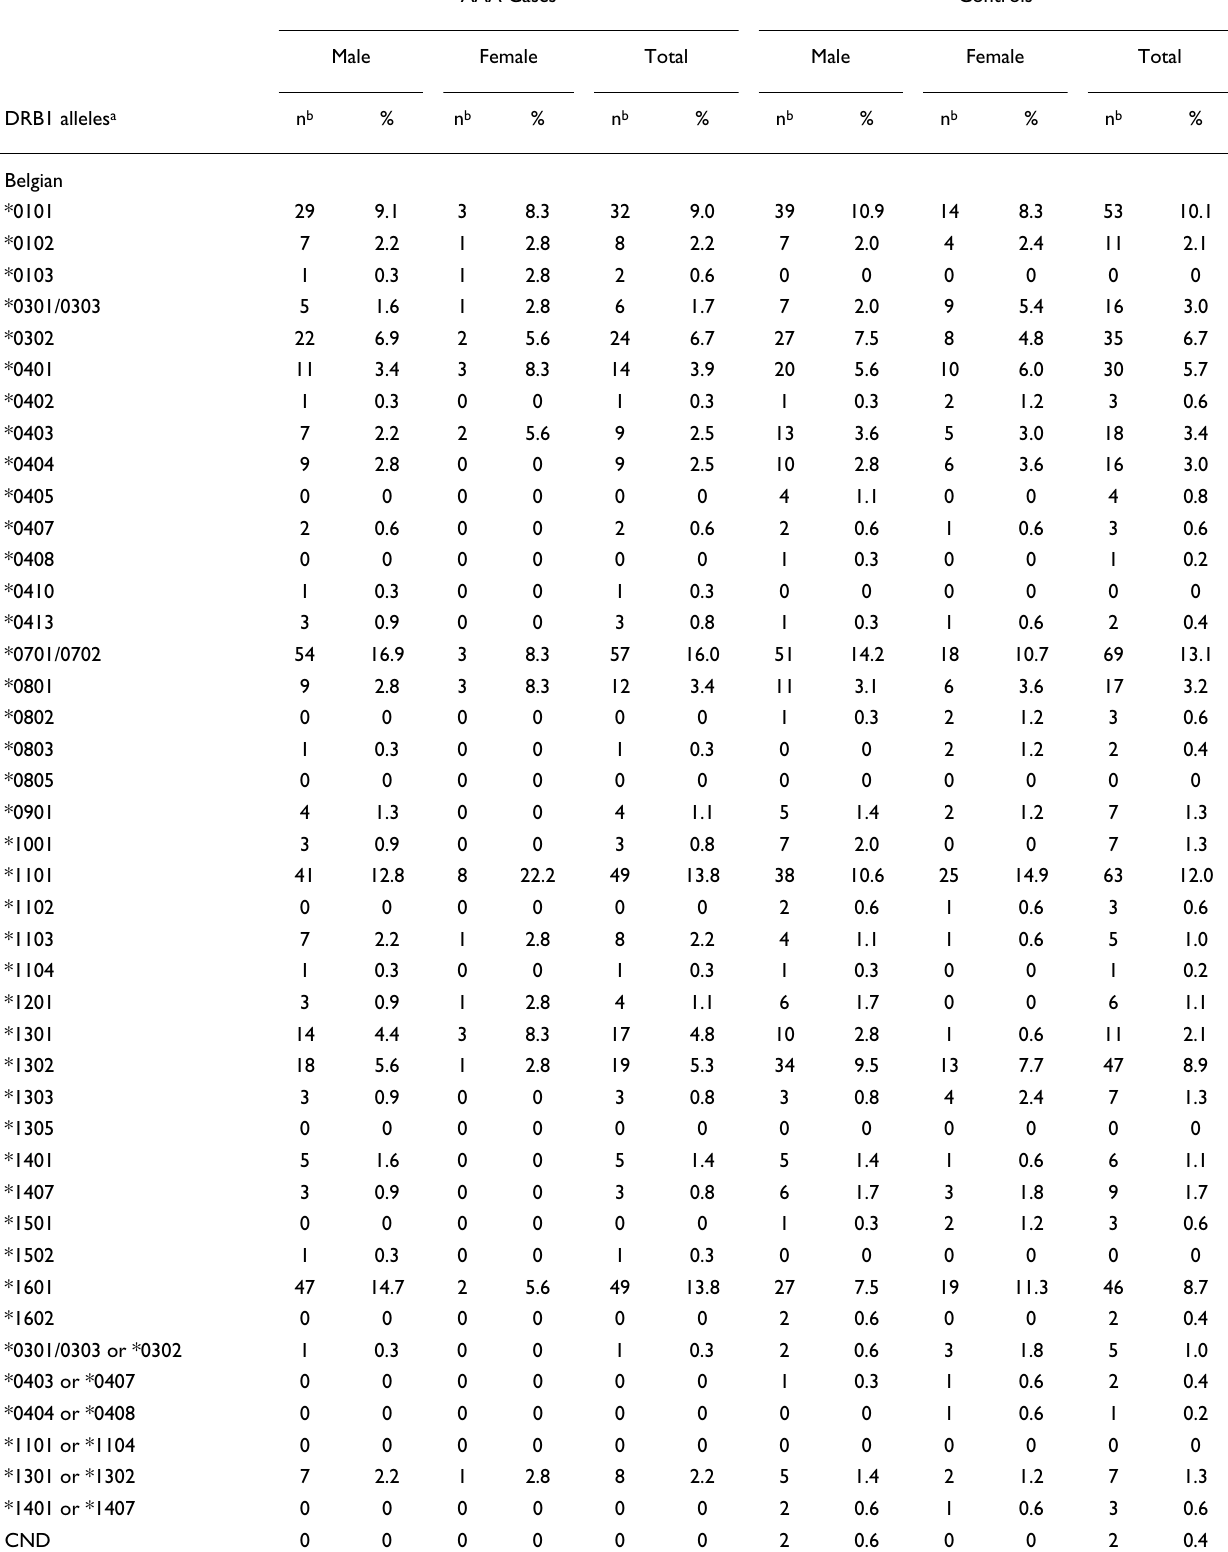
Table 3: HLA-DRB1 allele frequencies in AAA cases and